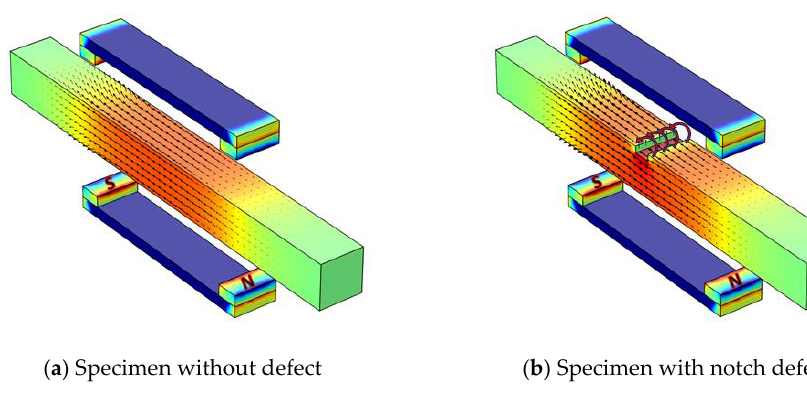
Figure 1. Schematic of the MFL phenomenon.